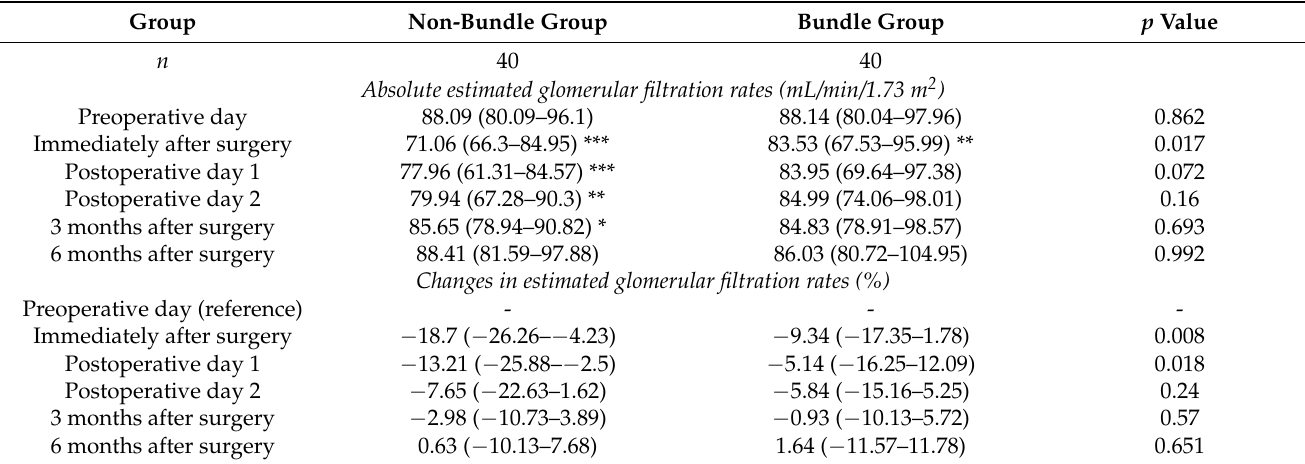
Table 2. Comparison of the perioperative absolute estimated glomerular filtration rates, and changes therein, between the two groups.